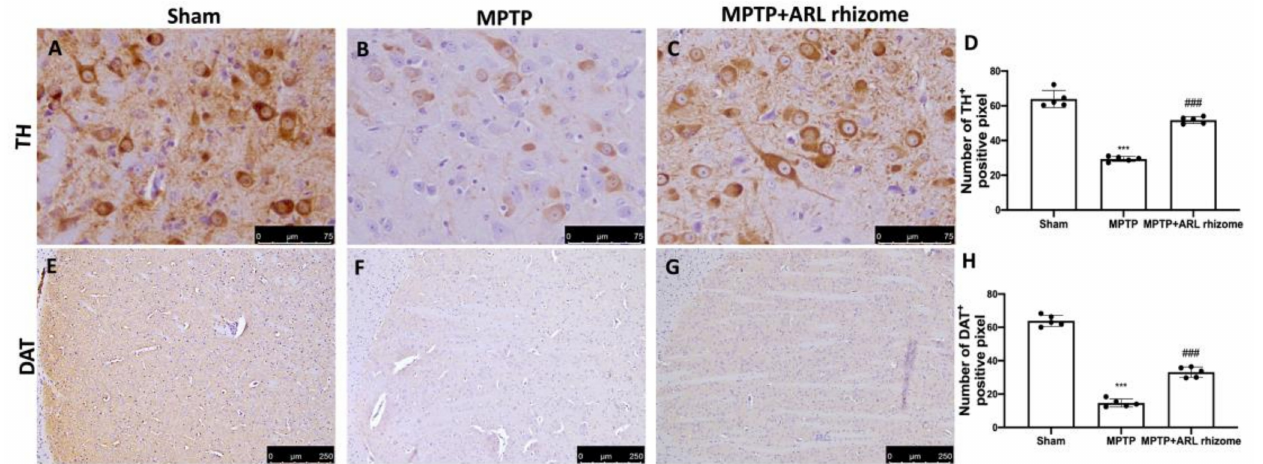
Figure 5. Effects of ARL rhizome on TH and DAT expression after MPTP-intoxication. Immuno- histochemistry for TH was evaluated in Sham ( A ), MPTP ( B ) and MPTP + ARL rhizome ( C ). The results are expressed as number of TH + positive pixel ( D ). The same analysis was performed for DAT on the brain sections of the Sham ( E ), MPTP ( F ), MPTP + ARL rhizome ( G ) groups. The results are expressed as number of DAT + positive pixel ( H ). The images are figurative of at least three independent experiments. Values = means ± SD of 5 animals in each group. *** p < 0.001 vs. Sham; ### p < 0.001 vs.